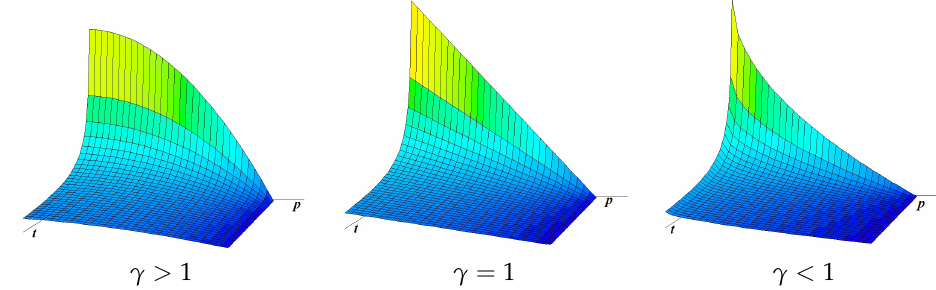
Figure 1. Demand functions D ( t , p ) when n >